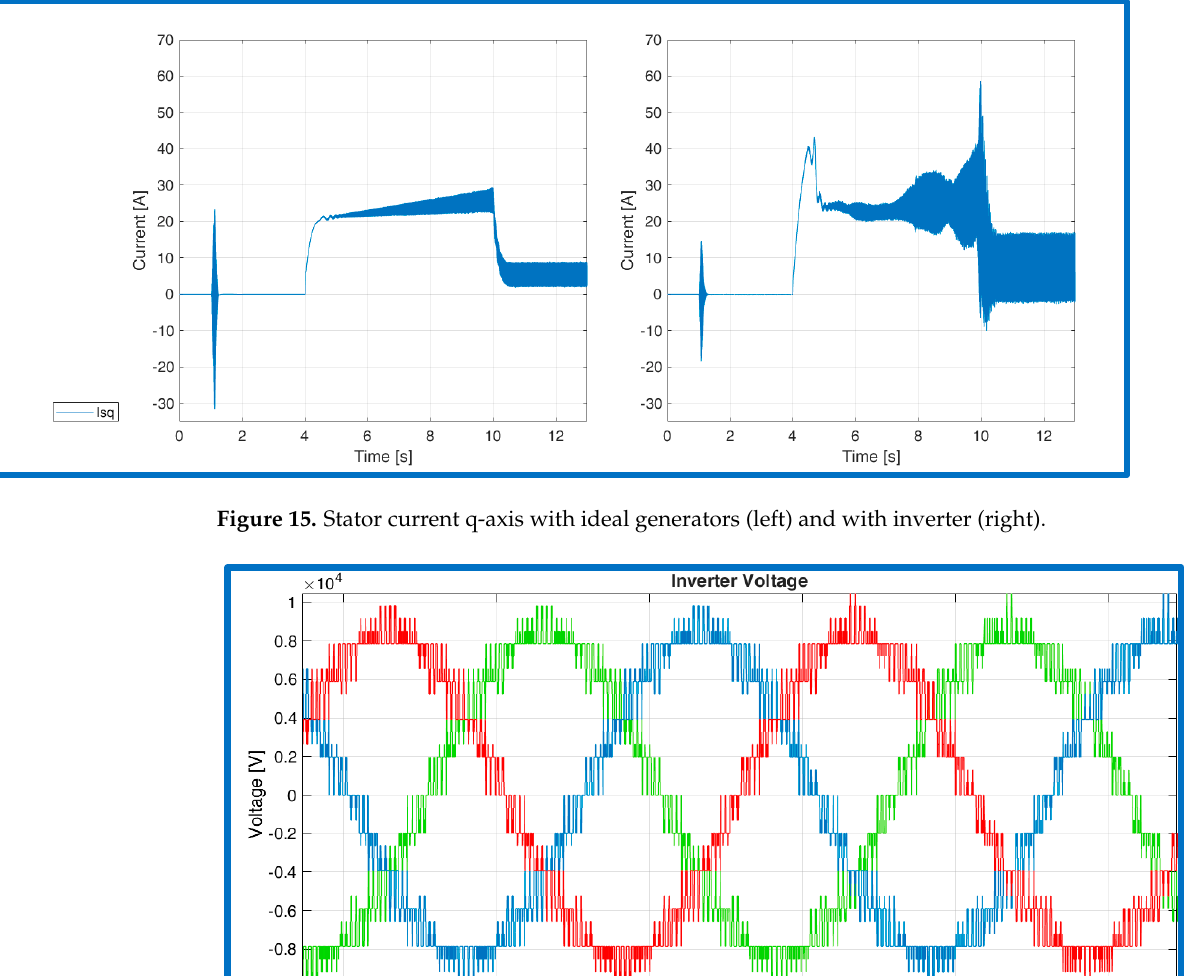
Figure 16. Three-phase inverter voltages.